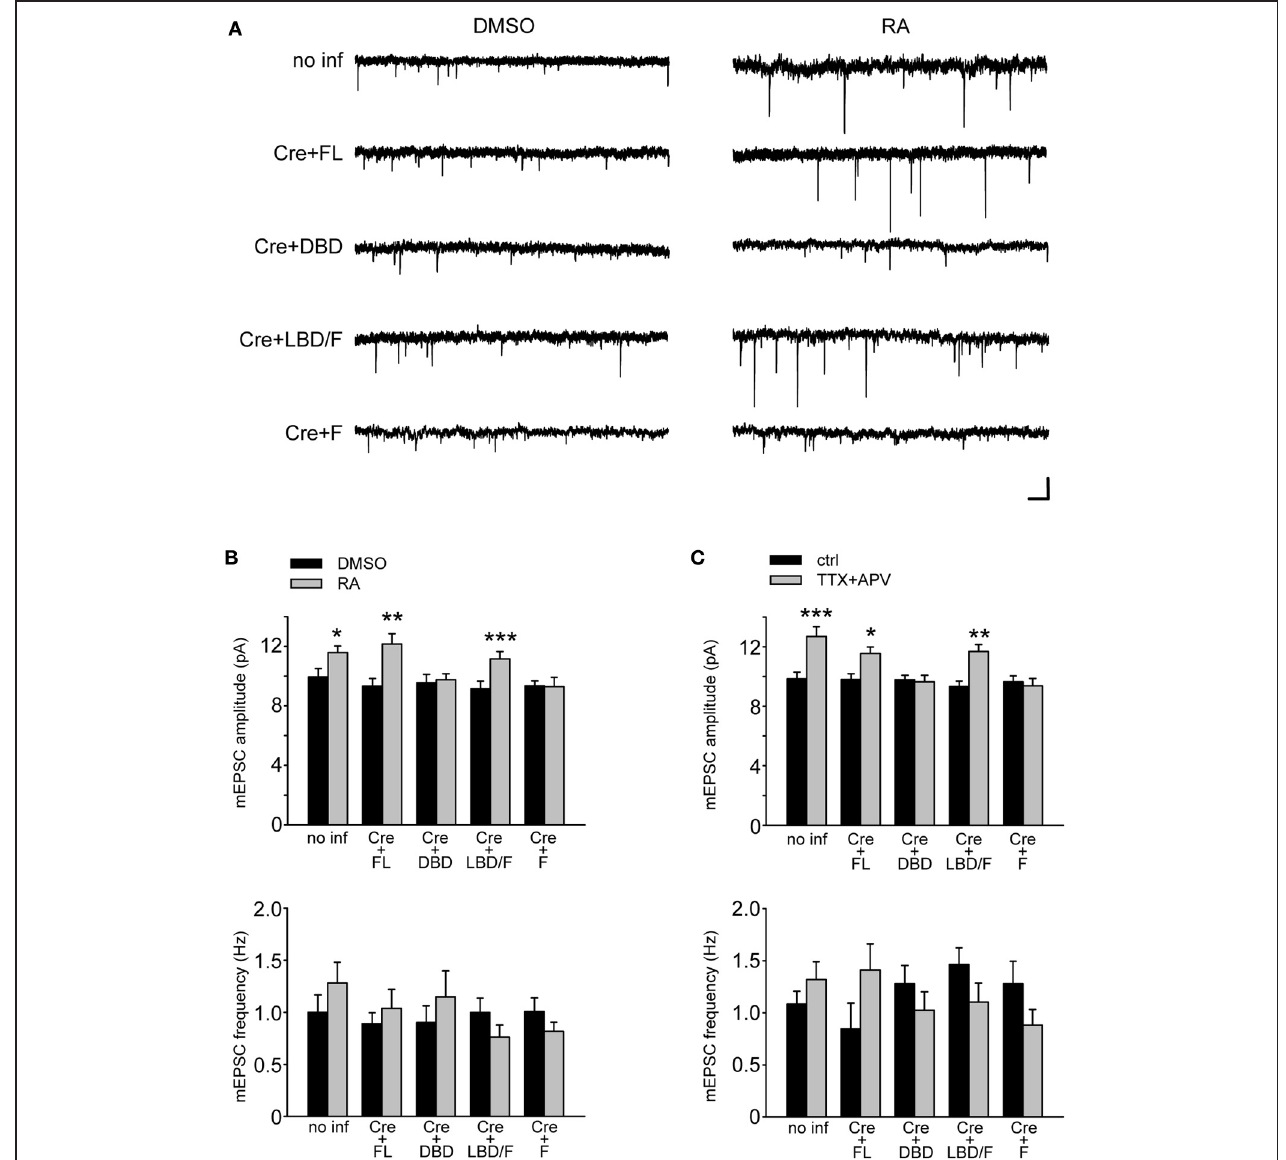
FIGURE 4 | Functional rescue of synaptic scaling in RAR α KO neurons RAR α expression. (A) Representative traces of mEPSCs from RAR α fl/fl hippocampal neurons infected with a bicistronic lentiviral vector coding for Cre-recombinase and either FL RAR α or truncated RAR α proteins. Neurons were treated with RA or with DMSO as control. Scale bars: 10pA, 0.5s. (B) mEPSCs amplitude and frequency were quantified showing rescue